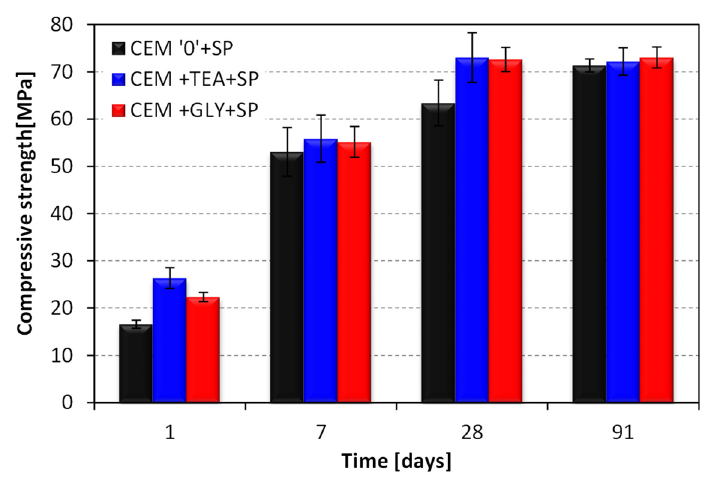
Figure 7. Compressive strength of mortars with superplasticizer, w/c = 0.4.